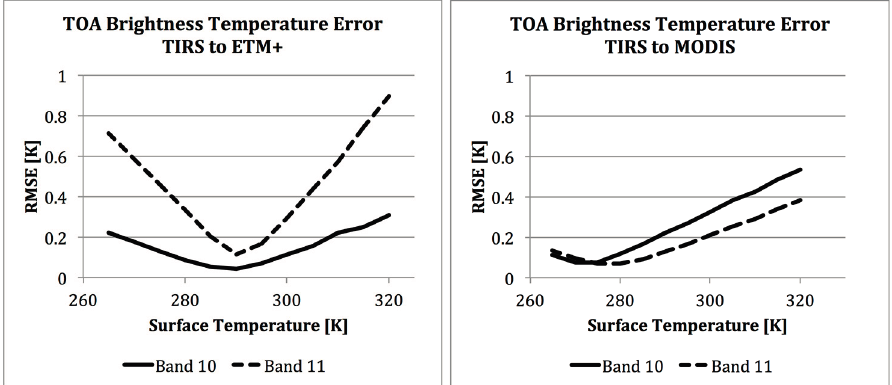
Figure 6. The estimated root-mean-squared error (RMSE) error in comparing the ETM+ ( left ) or MODIS ( right ) to TIRS brightness temperatures over a range of surface temperatures and through a variety of atmosphere types. The largest errors are due to less likely conditions, i.e. , a very warm surface in a very cold